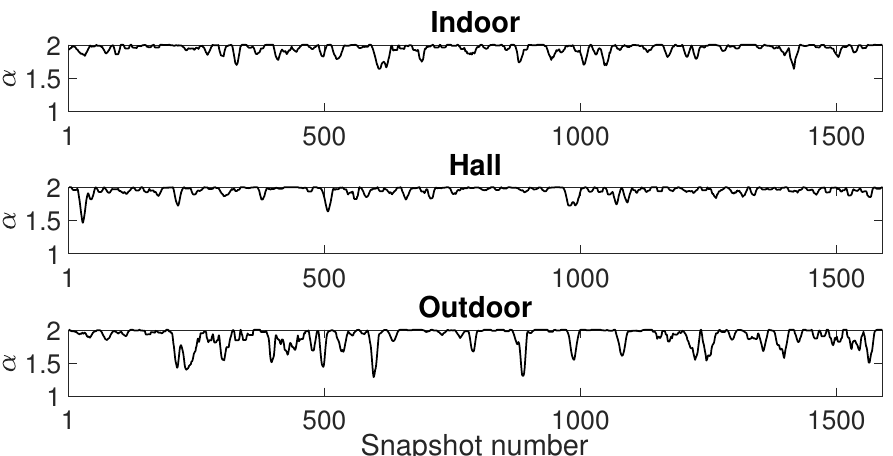
Figure 22. S α S model estimation: Sample window of 1500 with 10% of windows